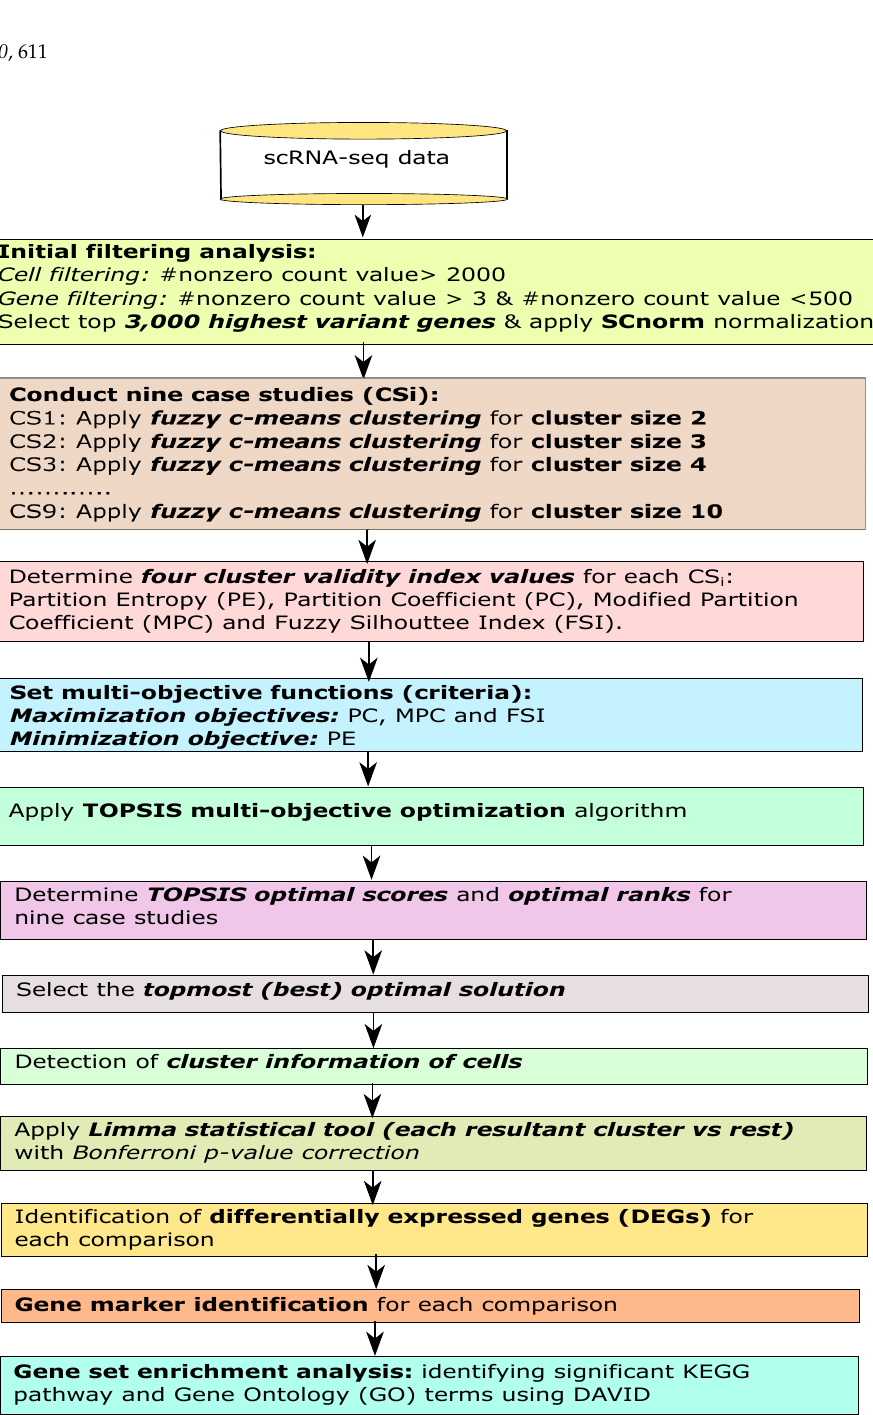
Figure 1. Flowchart of the proposed